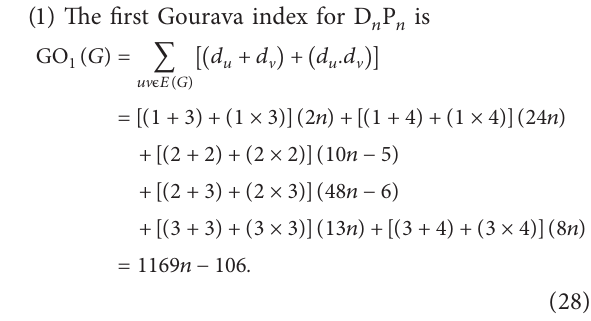
Figure 29: Plots of the second Gourava index for Bil . 3